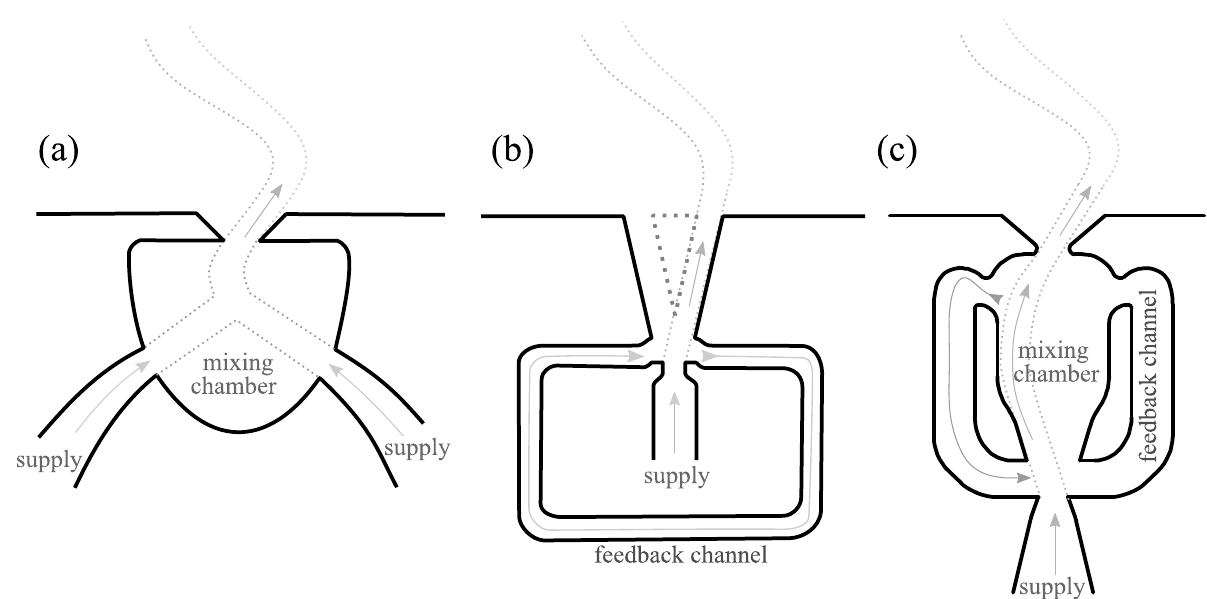
Figure 1. Main categories of fluidic oscillators (reproduced from Ref. [1]): ( a ) feedback ‐ free oscillator [5], ( b ) sonic oscillator [6], ( c ) oscillator with 2 feedback channels [7]. Fluidic oscillators were developed in the 1950s in the Harry Diamond Laboratories.